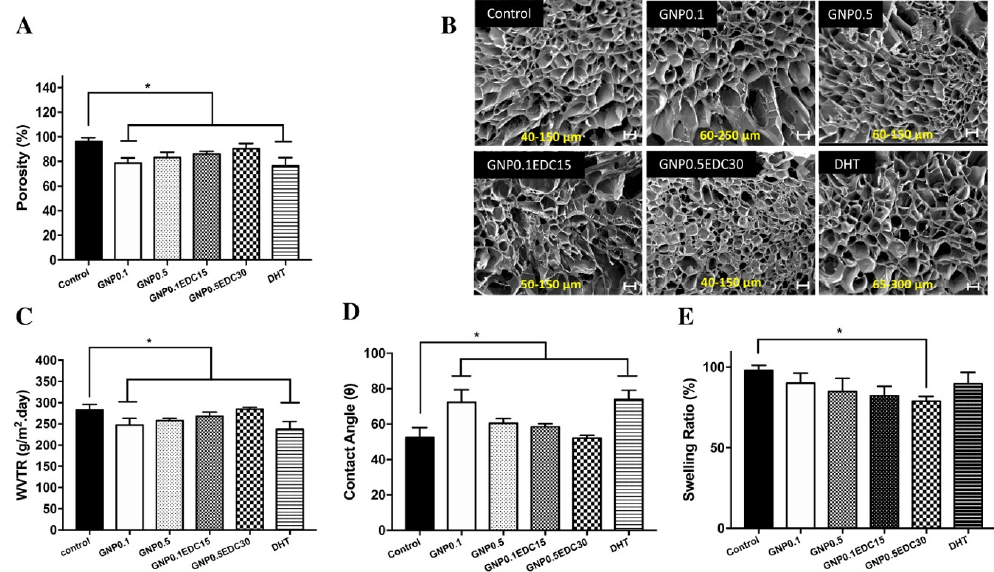
Figure 3. The effect of crosslinking on GS porosity. ( A ) Level of porosity of gelatin scaffold based on density displacement. Crosslinking resulted in reduction of porosity compared to control. ( B ) Representative SEM images of GS microarchitecture. Pore size range is depicted in yellow font. Double crosslinking and higher concentration resulted in identical microstructure with the control (30X magnification)/scale bar 100 µm. ( C ) WVTR measures water passage through the GS. Double crosslinking and higher concentration of crosslinker resulted in higher permeability. Only GNP0.1 and DHT demonstrated significantly lower permeability compared to the control as tested with Student’s t -test. ( D ) A lower contact angle indicates higher surface wettability of the GS. Double crosslinking and higher concentration of crosslinker resulted in higher wettability. Only GNP0.1 and DHT demonstrated significantly lower wettability compared to the control as tested with Student’s t -test. ( E ) Swelling ratio indicates the water absorption capability of GS. Double crosslinking and higher concentration of crosslinker resulted in lower water absorption. Only GNP0.5EDC30 demonstrated